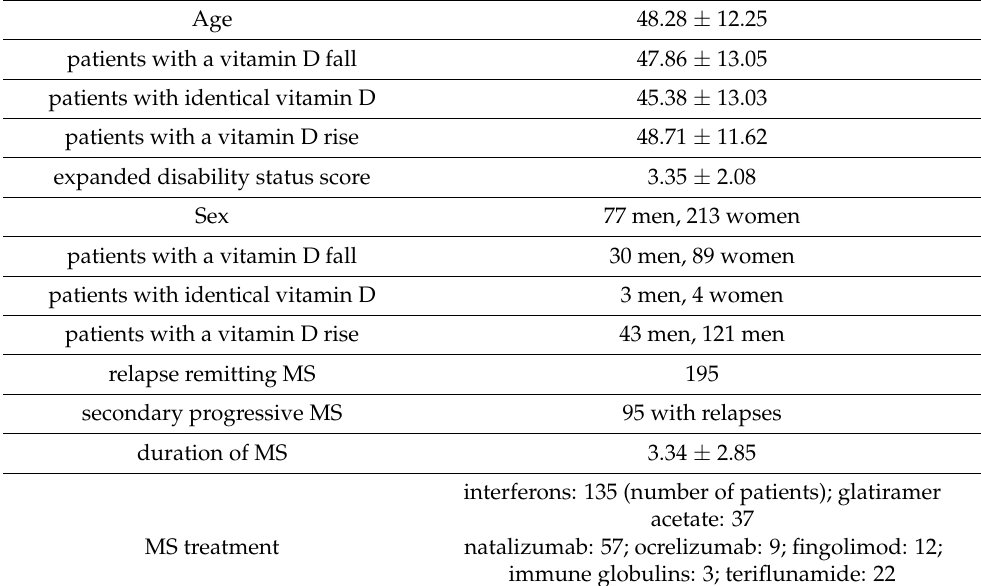
Table 1. Characteristics of MS